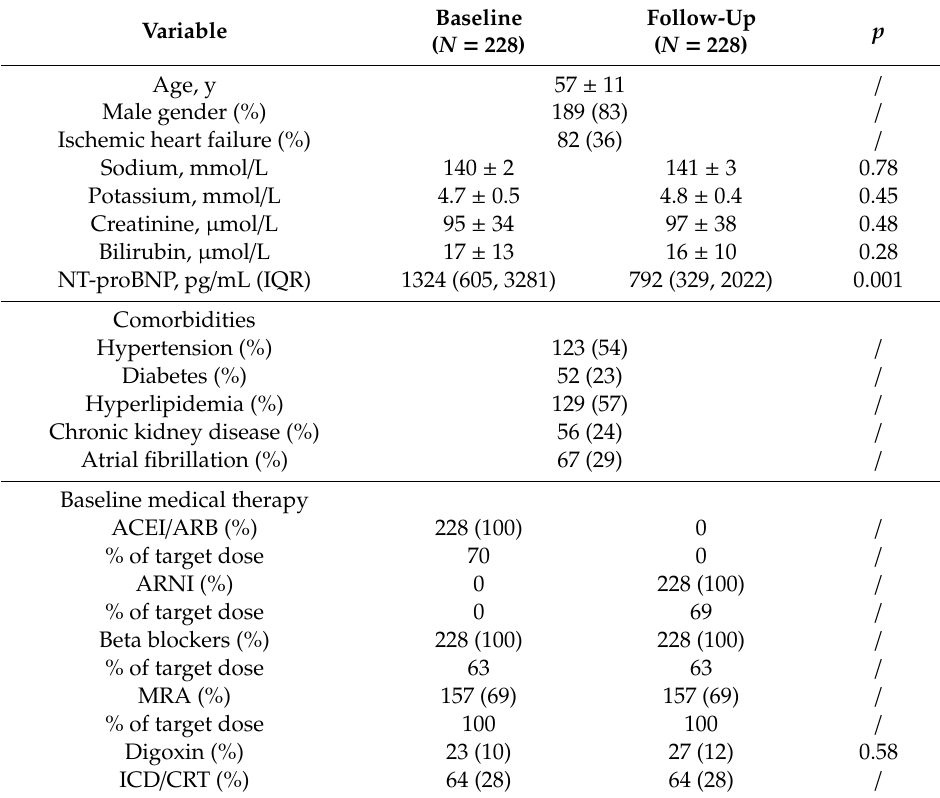
Table 1. Baseline patient